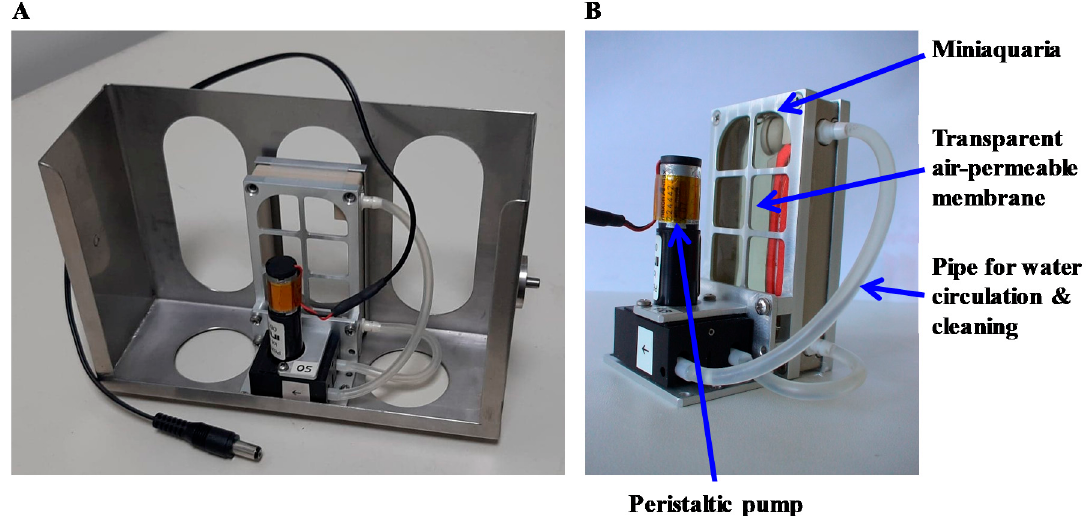
Figure 3. ( A ) Gondola of the rotor allowing the centrifugation of eight miniaquariums. ( B ) Miniaquariums have both large sides covered with transparent air-permeable membranes. These miniaquariums have a water circulation loop provided by a peristaltic pump with waste removal by an activated carbon filter and an osmotic pump that delivers the food. Each miniaquarium is 80 mm long, 40 mm wide, and 20 mm high.